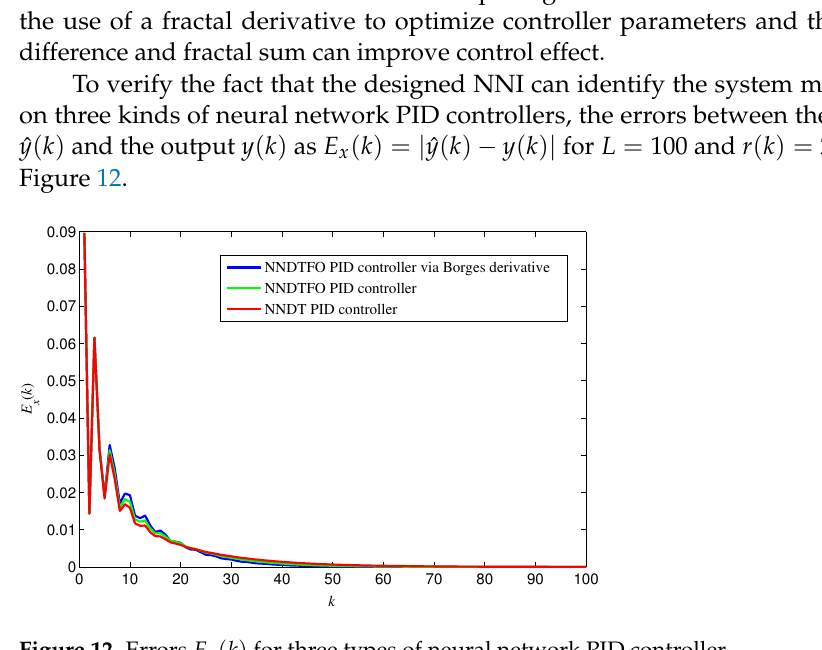
Figure 12. Errors E x ( k ) for three types of neural network PID